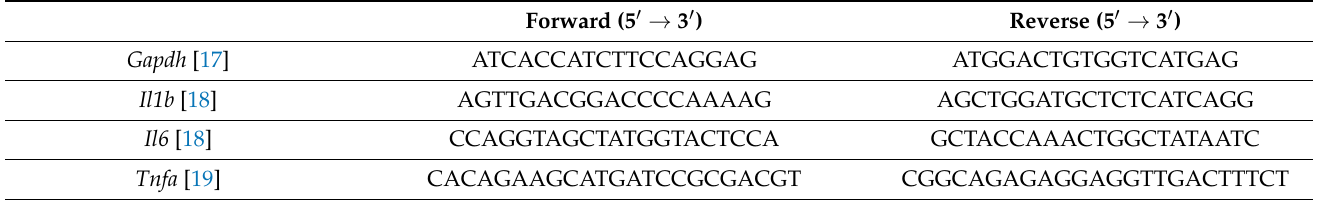
Table 1. Primer lists for real-time quantitative PCR